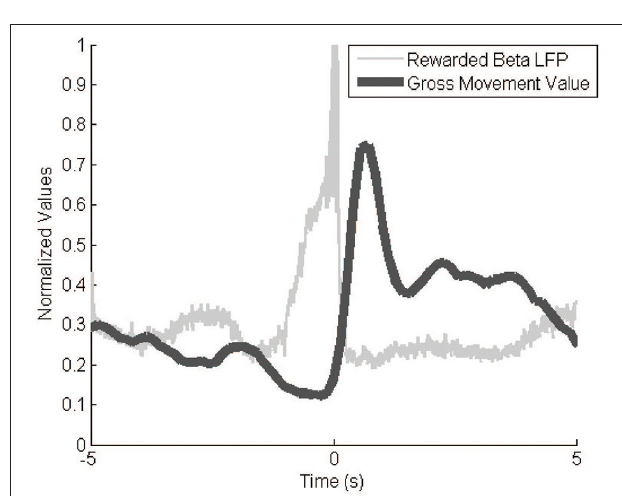
FIGURE 6 | GMV vs. LFP beta power. The inverse relationship between signal power and the GMV is apparent during reward events. The filtered (10–30 Hz) and rectified neural signals and the GMV were averaged over 287 reward events while the animal was freely behaving in its cage. GMV is normalized to the maximum and minimum values from the entire